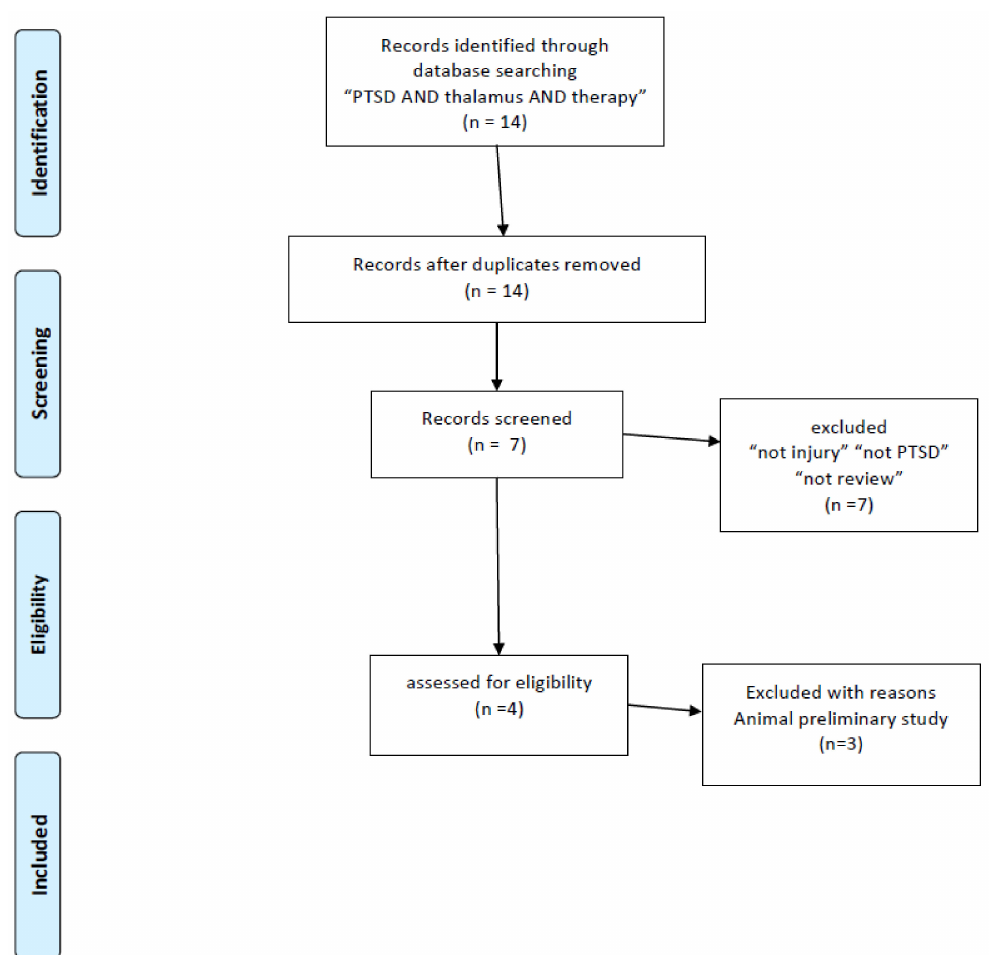
Figure 4. PRISMA flow diagrams [25] of literature research for contribution of thalamus physiology to therapy in